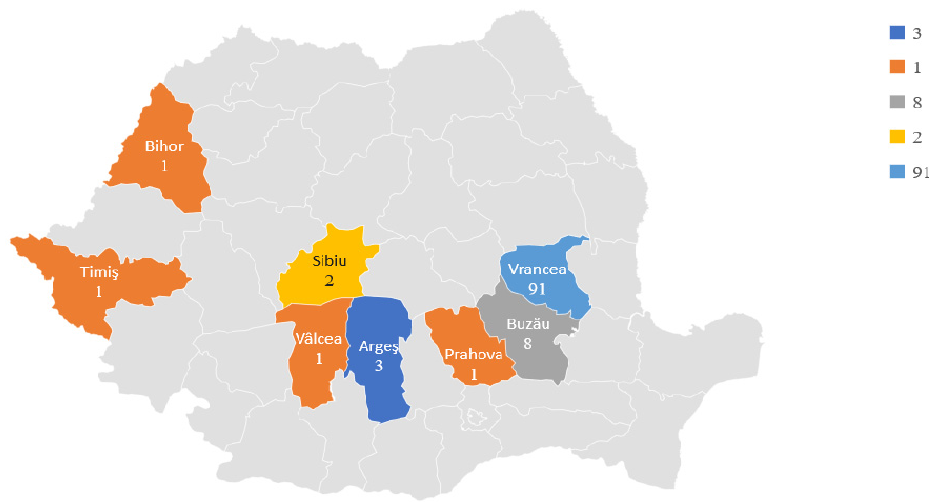
Figure 3. Earthquakes in Romania depending on the location of the epicenter in the CRESTA zones. Source: developed by the author based on the ROMPLUS catalogue data of 30 th of Septem- ber 2021, www.infp.ro/index.php?i=romplus (accessed on 17 November 2021)